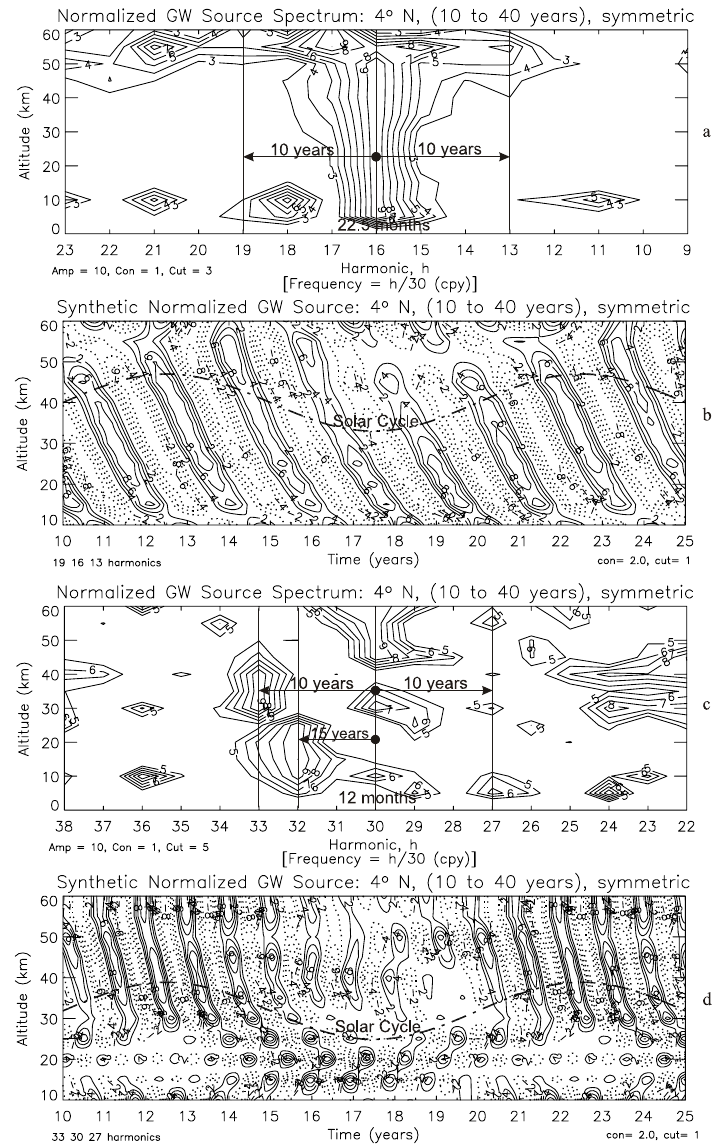
Fig. 12. Gravity wave (GW) momentum source (MS) for the time span from 10 to 40 years, based on a wave source in the troposphere that is time independent. To eliminate from view the exponential variation of the MS, a normalization is applied that preserves the time-dependent SC modulation of interest. Although the vertical resolution of the model is about 0.5km, the MS is recorded with 5km height increments to reduce the model output. The results therefore appear ragged. (a) With the maximum MS normalized to the value 10, and the lowest contour at 3, the spectrum peaks at h =16 (22.5 months), consistent with the zonal wind oscillations in Fig. 4a. The side lobes for the 10-year SC modulation are also evident. (b) The synthesis for the spectral features at h =13, 16 and 19 shows a pronounced amplitude modulation, which is essentially in phase with the imposed SC (dashed line), and with the zonal winds in Fig. 4b. With contour intervals of 2, the maximum amplitudes are close to 10 (as defined), while the minimum values are only around 5. This demonstrates that the GW source significantly amplifies the SC modulation of the QBO, which represents a new mechanism for the solar influence on the lower atmosphere. (c) Similar to (a) but for the normalized MS that drives the symmetric annual oscillation or EAO shown in Fig. 7. At h =30, the 12-month periodicity is evident, and the spectral features at h =27, and at 33 in particular, describe the 10-year SC signatures. As in Fig. 7a, the 15-year signature is also pronounced. (d) The synthesis of the harmonics h =33, 30 and 27 describes the SC modulation of the MS for the EAO, which is in phase with the imposed solar forcing and with the zonal winds in Fig.